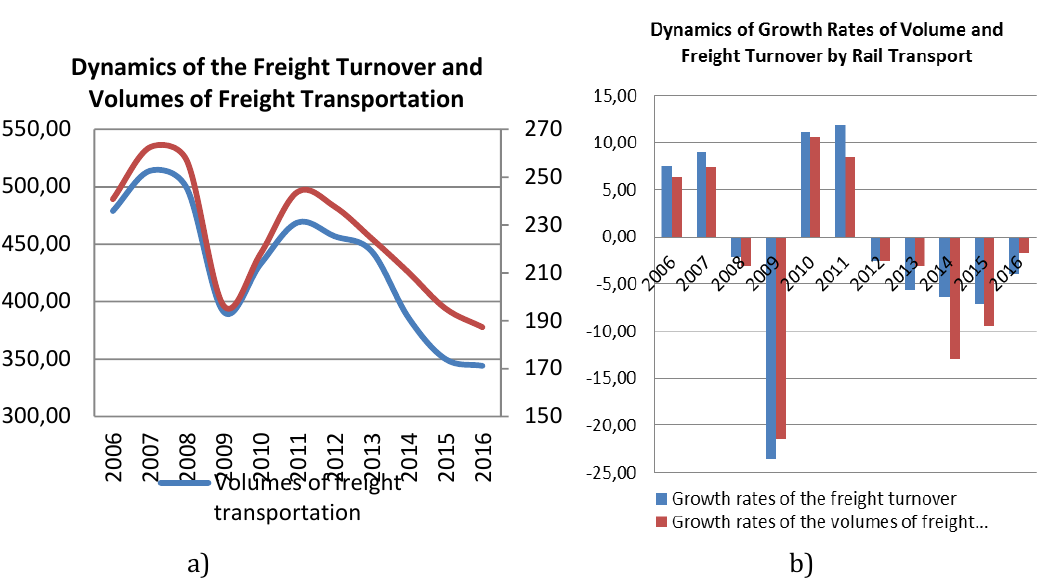
Fig. 5. Dynamics of Absolute and Relative Values of the Freight Turnover and Volumes of